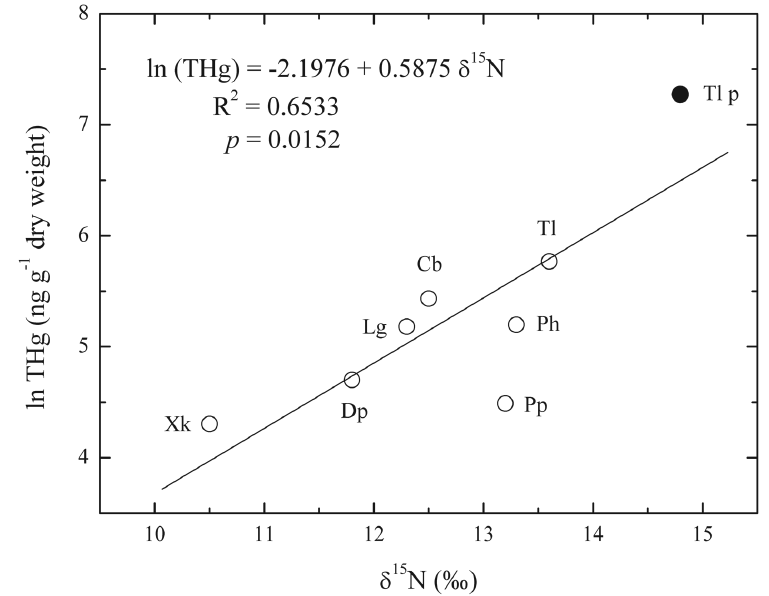
Figure 1 - Relationship between δ 15 N and THg concentration (log-transformed) for Trichiurus lepturus (adult specimens) and its preferred prey. Tl p: Trichiurus lepturus predator; Tl: T. lepturus prey; Cb: Chirocentrodon bleekerianus ; Lg: Lycengraulis grossidens ; Dp: Dorytheutis plei ; Xk: Xiphopenaeus kroyeri ; Pp: Peprilus paru ; and Ph: Pellona harroweri.